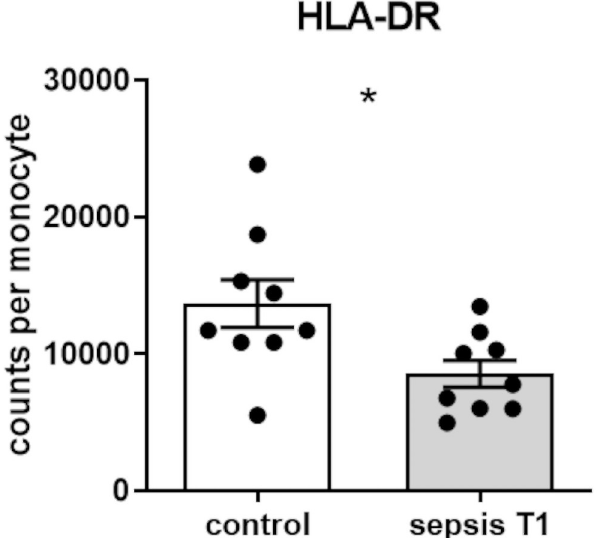
Fig 3. HLA-DR expression on monocyte surface. Surface expression of HLA-DR on CD14 ++ -monocytes at the time of sepsis diagnosis (T1) compared to matched control patients analyzed in whole blood samples using flow cytometry (p < 0.05, Mann-Whitney U test, control patients n = 9, patients with sepsis n = 9, mean ± SEM).